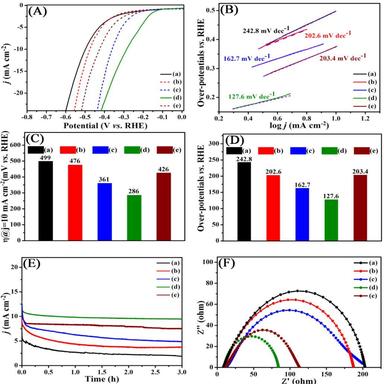
(A) HER polarization curves of the as-prepared catalysts at 5 mV s−1 in 1.0 M KOH. (B) Corresponding Tafel plots in 1.0 M KOH. (C) Histograms of overpotential at 10 mA cm−2 obtained from HER polarization curves. (D) Histograms of Tafel plots. (E) i–t chronoamperometric curves for the as-prepared catalysts at −0.45 V vs RHE. (F) Electrochemical impedance spectroscopy (EIS) Nyquist plots of the as-prepared catalysts in 1.0 M KOH. The as-prepared catalysts are (a) Pd/C, (b) Pd/CNTs, (c) Pd/CNTs-DPHE-1, (d) Pd/